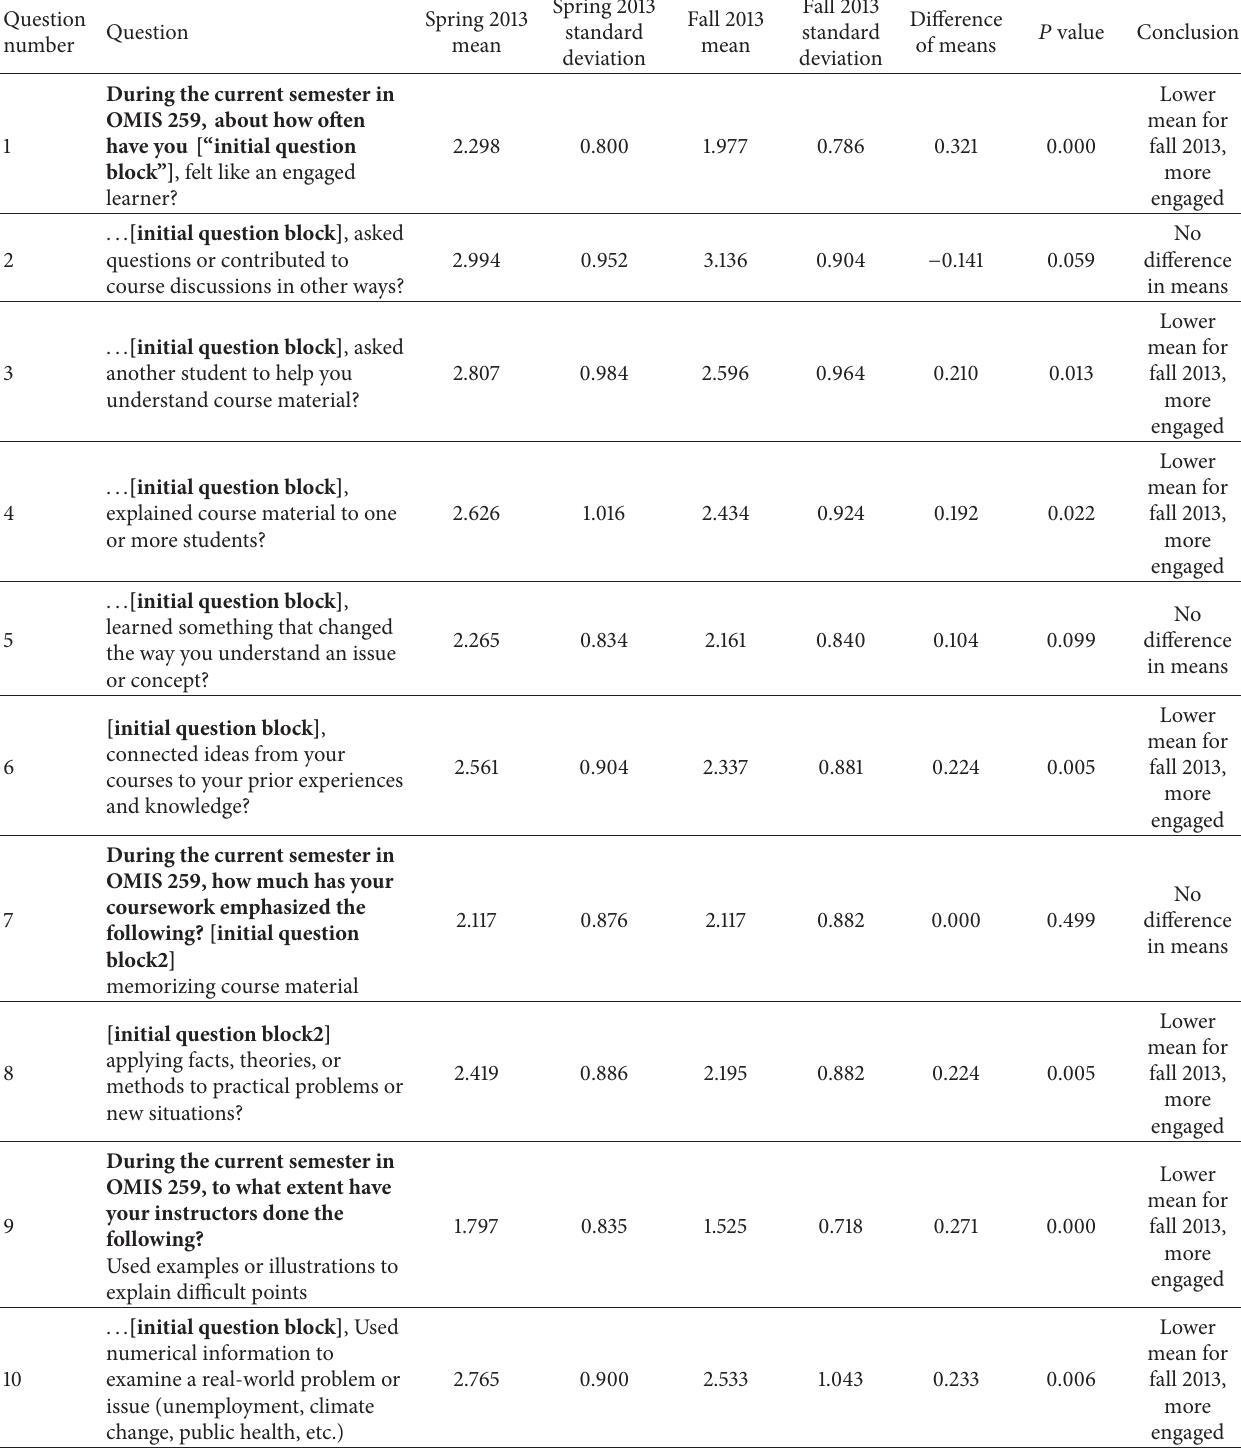
Table 2: Engagement question response means, their differences, 𝑃 values for statistical significance of differences and resulting